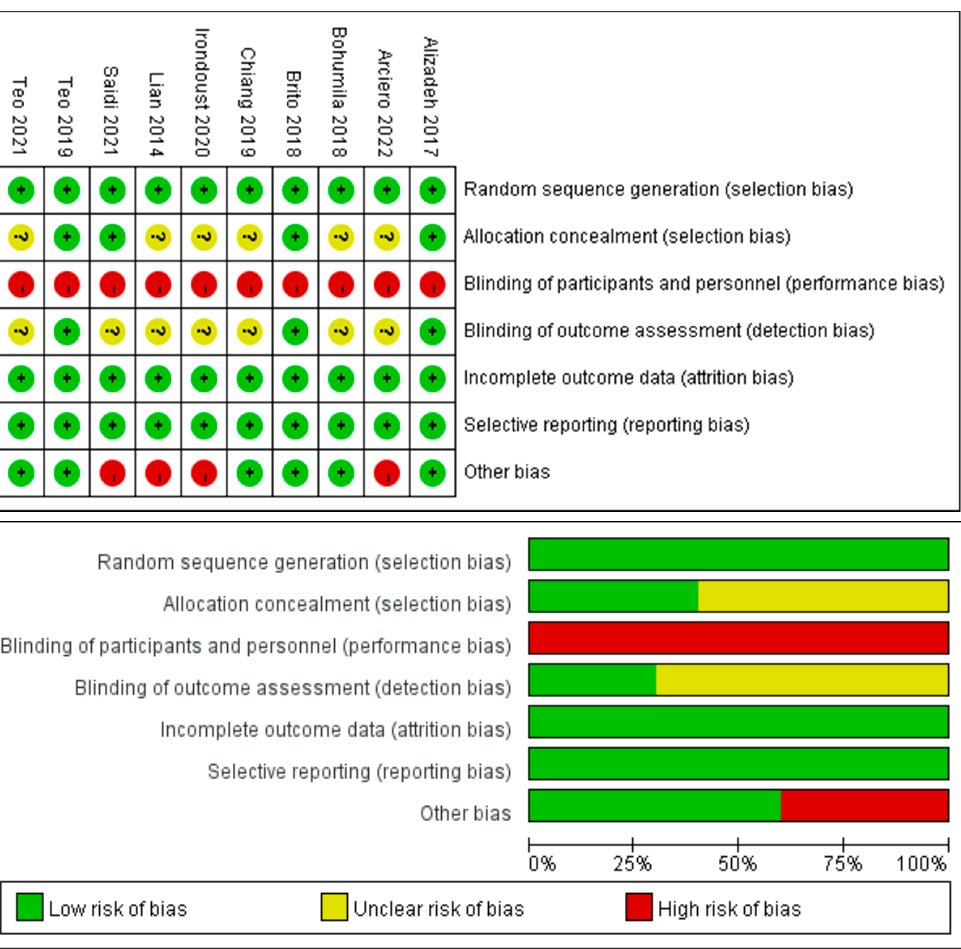
Figure 2. Risk of bias assessment for randomized controlled trials [25–34]. Table 1. Time-dependent effects of physical activity on cardiovascular risk factors in adults.